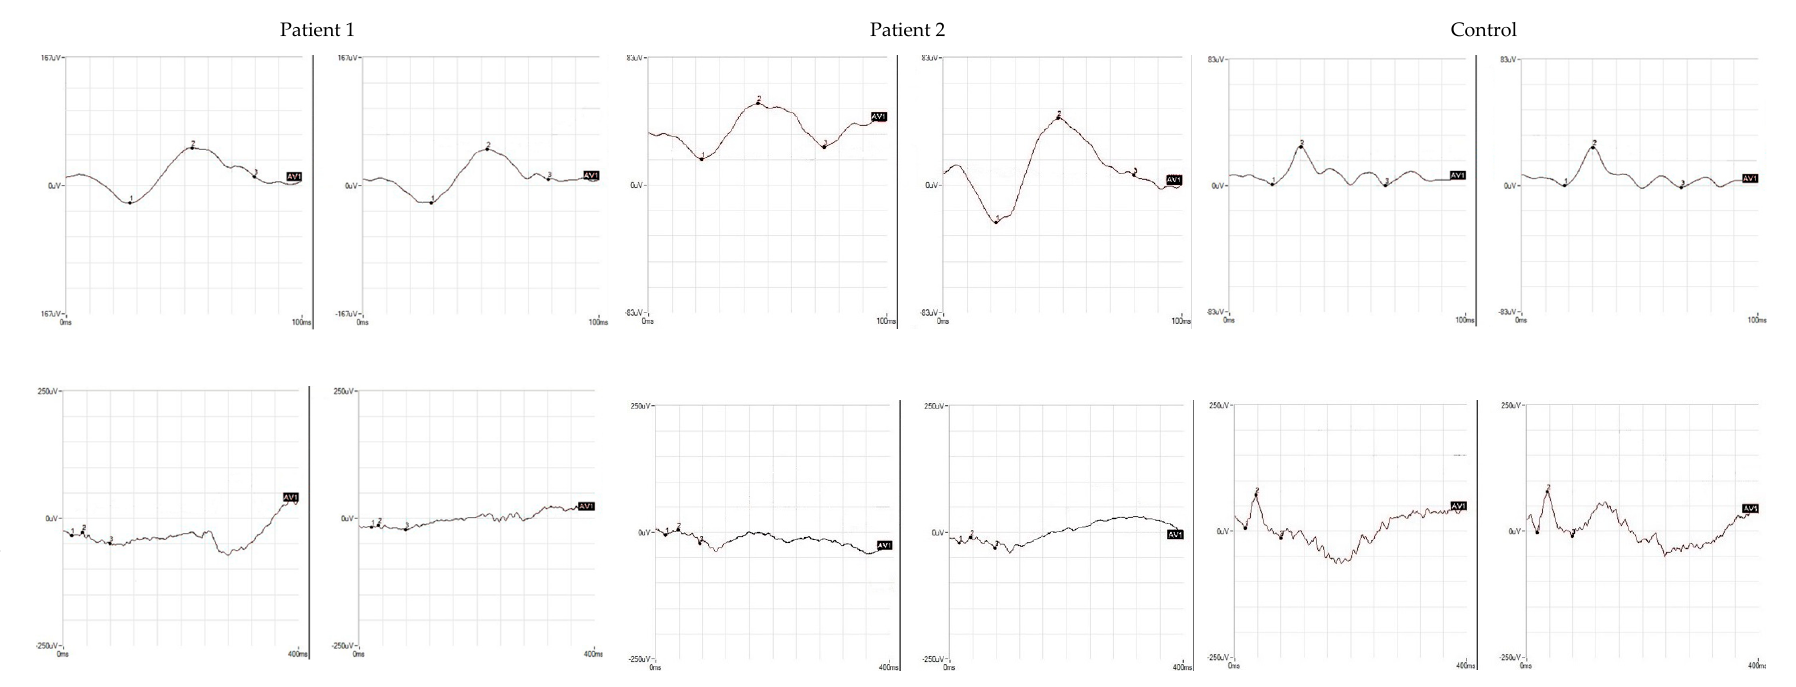
Figure 4. Specialized ERG responses. S-cone and ML-cone mediated ERG recordings from the patients and a control subject. Note that S-cone ERG is much larger than normal, delayed and with a simplified waveform as compared with the normal control.